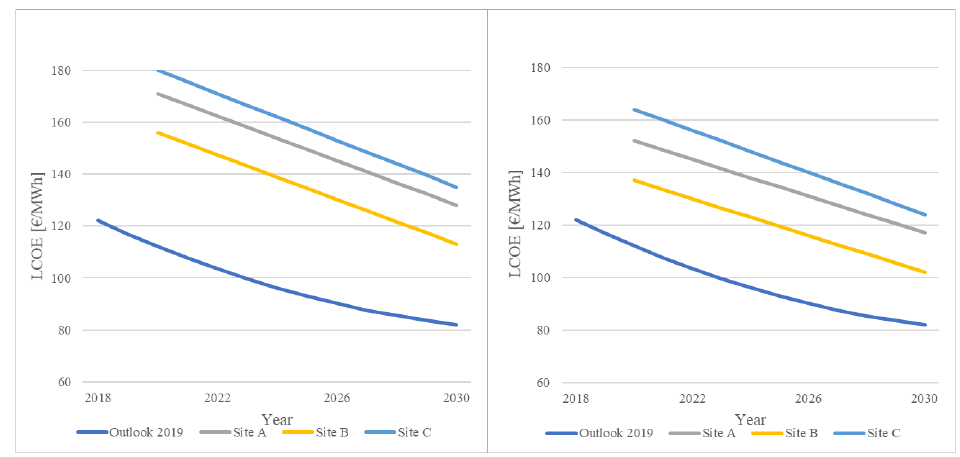
Figure 22. Levelized Cost Of Energy (LCOE) decrease due to cost reduction for Spar-buoy ( left ) and Hexafloat ( right